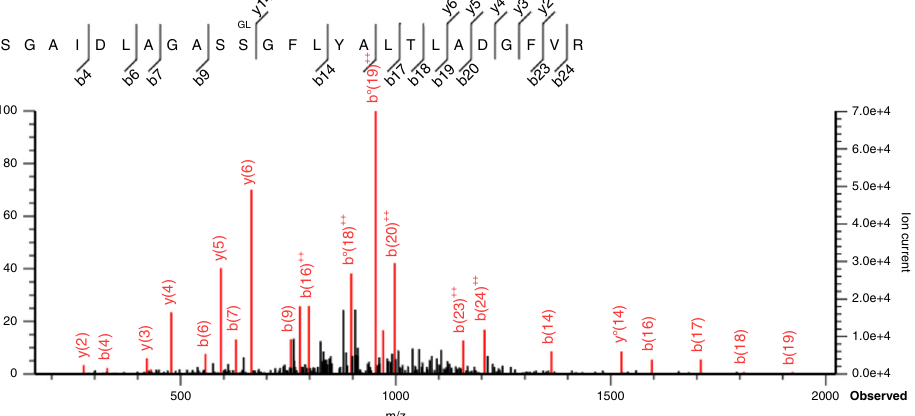
Fig. 7 Mass spectral analysis of pimeloyl-ACP synthesis and MS/MS detection of a trapped active site glutarate adduct. Mass spectral analyses of intact ACP species a – d and of the modi fi ed active site peptide of the BioZ C115S mutant protein e . a Reaction containing malonyl-ACP and glutaryl-CoA as substrates and lacking AtBioZ b . Reaction containing malonyl-ACP and glutaryl-CoA as substrates supplemented with AtBioZ. c and d tested glutaryl-ACP and malonyl-CoA as substrates with or without SfBioZ addition. e MS/MS spectra of the active site peptide of the AtBioZ C115S puri fi ed from an E. coli expression strain. Analysis by the MASCOT program (inset at top right) indicated the presence of glutaryl modi fi cations of serine residues 115 and 116. Traces of pimeloyl modi fi cation were also present whereas no malonyl modi fi cation was